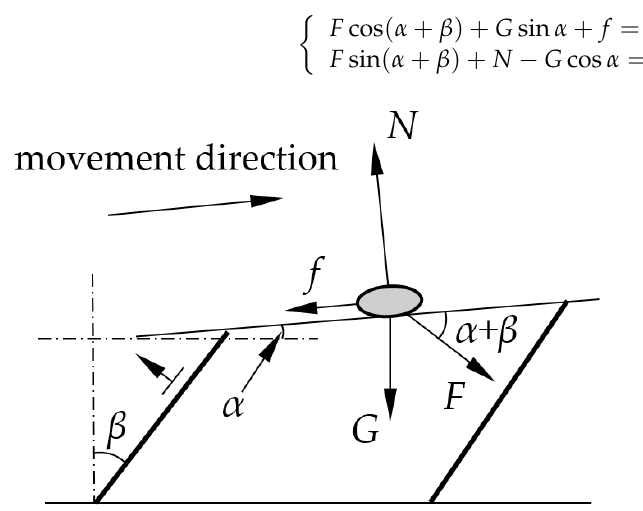
Figure 4. Sketch of reverse slip force analysis.